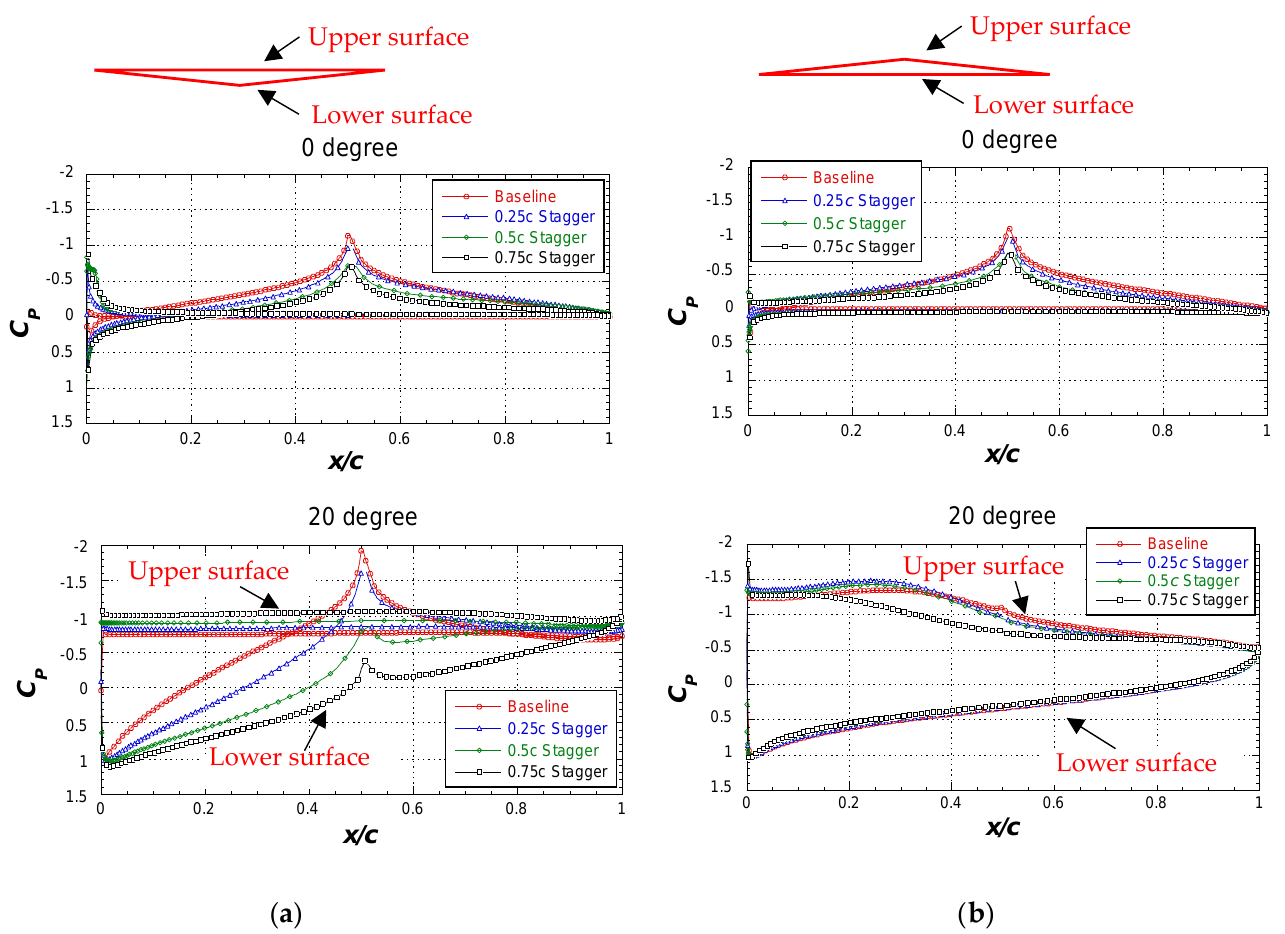
Figure 11. Comparison of pressure coefficient in airfoil surface of the staggered biplane configuration (CFD results): ( a ) upper element; ( b ) lower element.